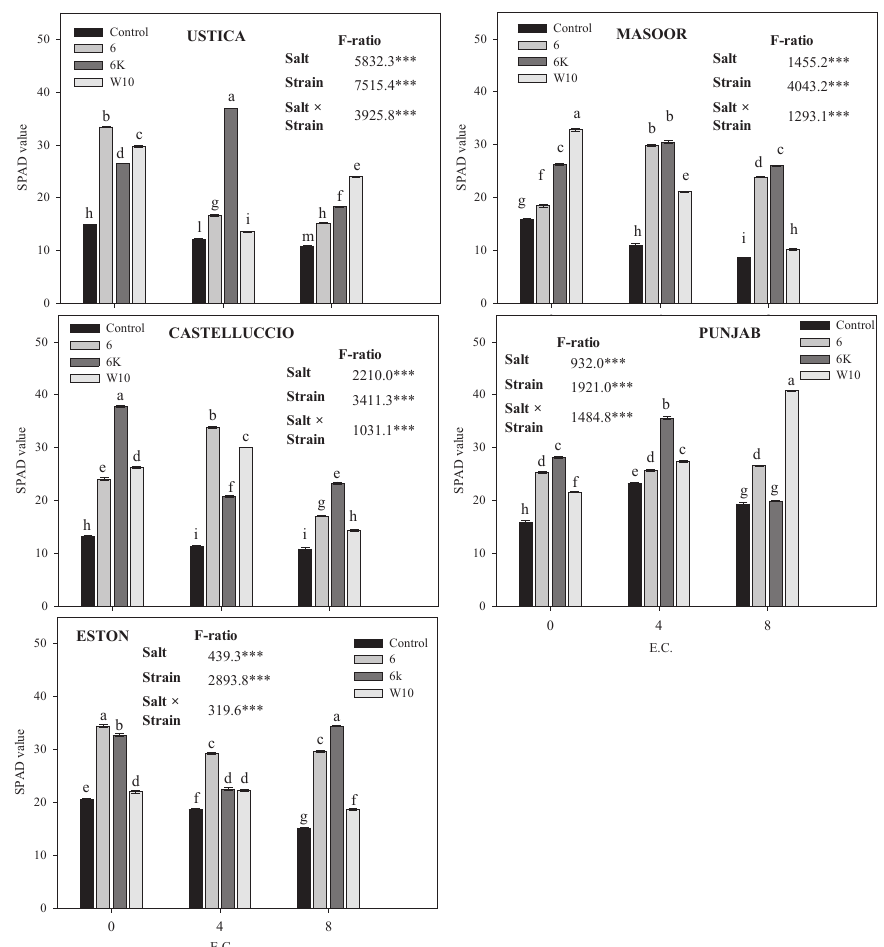
Fig. 3: Chlorophyll contents (SPAD value) detected in leaves of Ustica (UST), Castelluccio (CAST), Eston (EST), Masoor 85 (MAS) and Punjab (PUN) lentils, 16 days after the inoculation with 6, 6K and W10 strains in presence of different NaCl salinity concentrations (0, 4 and 8 dS m -1 ). Bars represent the mean ± SE. Different letters indicate significant differences (P ≤